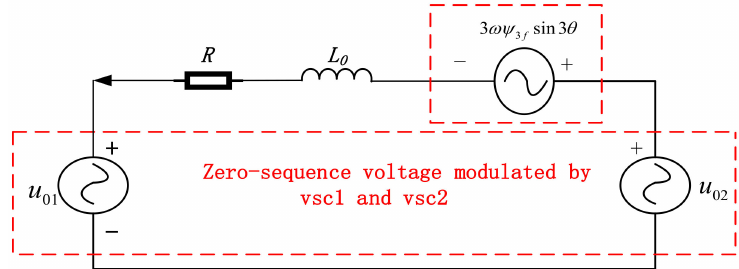
Figure 2. Zero-sequence equivalent circuit of